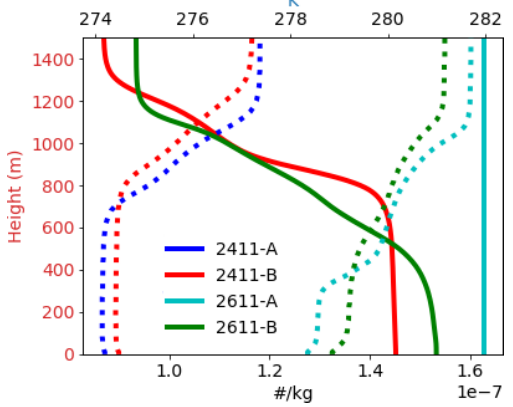
Figure 8. Number mixing ratio (solid) and potential temperature (dashed) vertical profiles at 17:00LST for constant vertical aerosol profiles on 24 November (blue) and 26 November (turquoise) and varied aerosol vertical profiles on 24 November (red) and 26 November (green). The mixing ratios for constant aerosol ver- tical profiles (blue and turquoise) remain constant in time for both simulations; the solid blue line is equivalent to the solid turquoise